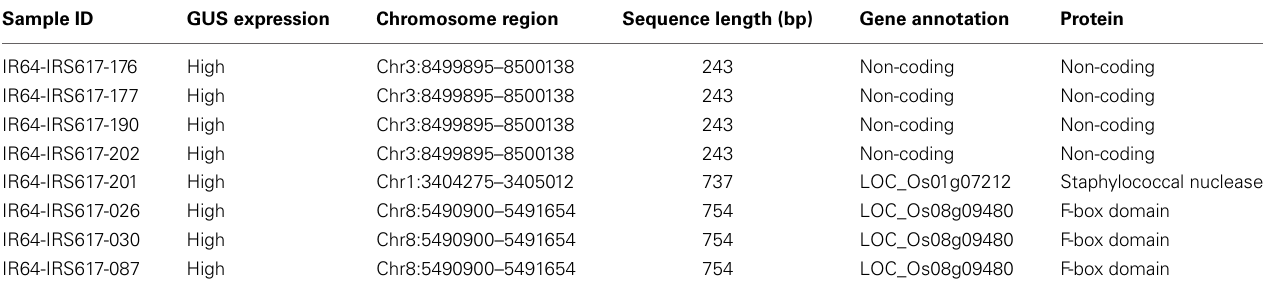
Table 3 | Chromosomal localization and annotation of putative safe harbor loci identified in transgenic rice plants obtained by using ZFN